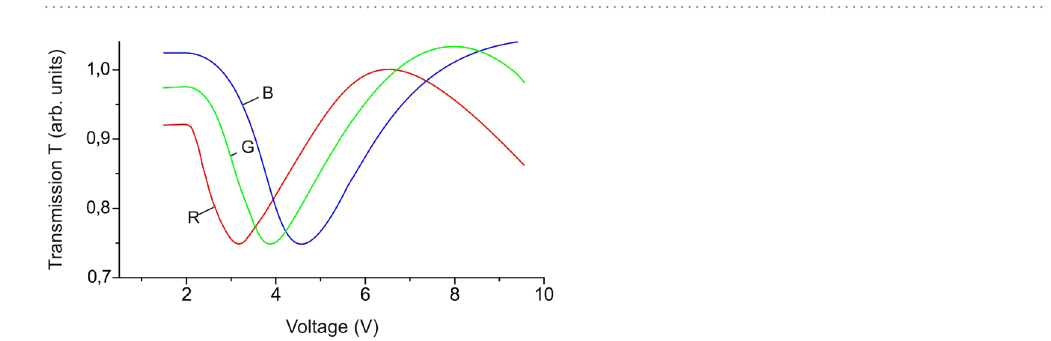
Figure 6. The transition from the nematic polygonal to nematic fan texture. ( a ) The micrographs of domains ensemble at various values U . ( b , c ) Monochromatic light transmission T vs. electric voltage U . Laser radiation was transmitted through a cell formed on the basis of sample 15 with the top plate: ( b ) rubbed; ( c ) treated by surfactants.